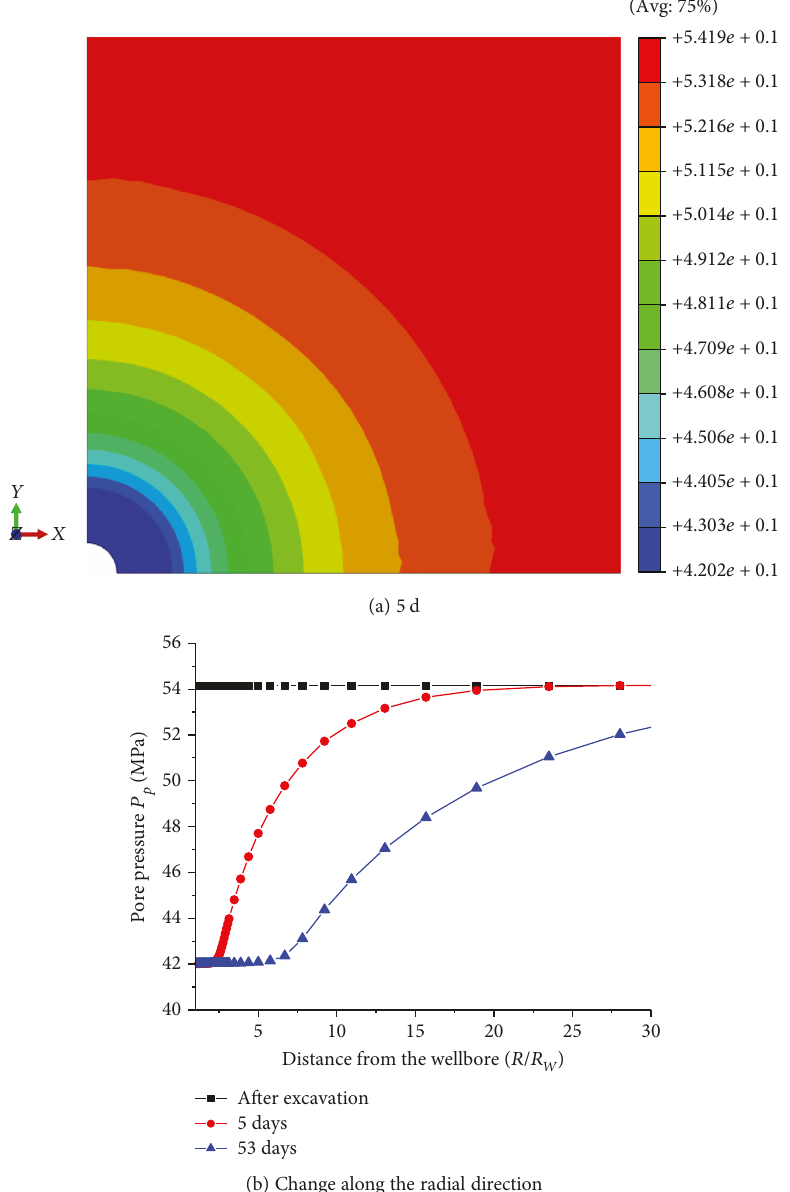
Figure 10: Pore pressure distribution of the wellbore after